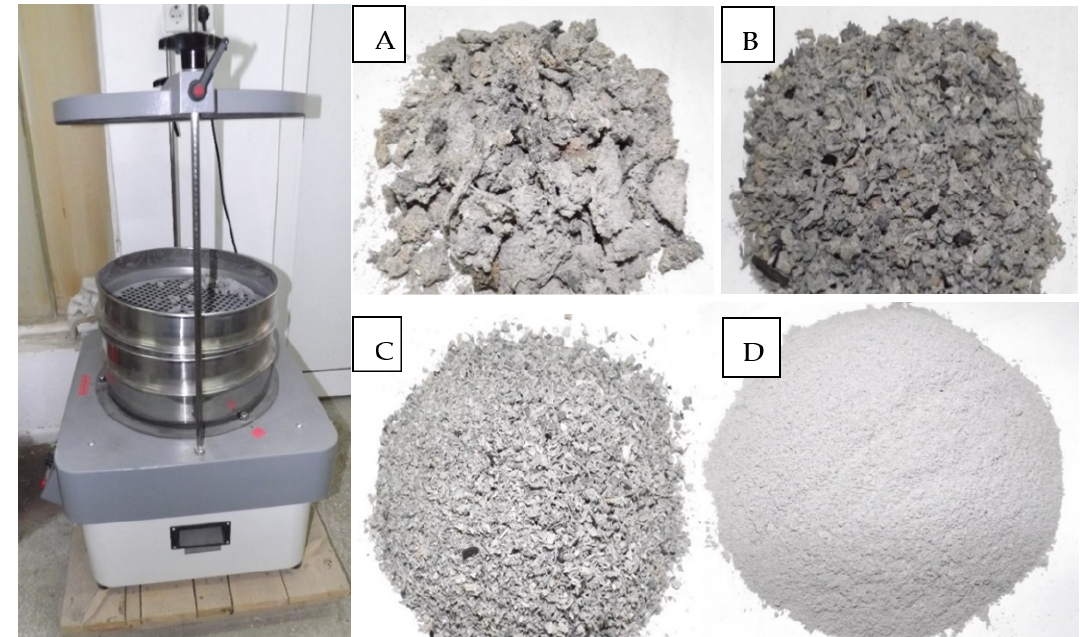
Figure 2. The sieving equipment and steps for sieving ash from sunflower stalks obtained by free burning: ( A ) Material left in the 20 mm sieve after 5 min of sieving; ( B ) material left in the 10 mm sieve after 5 min of sieving; ( C ) material left in the 2 mm sieve after 5 min of sieving; ( D ) material passed through the 300 µm (0.3 mm) sieve after 5 min of sieving.